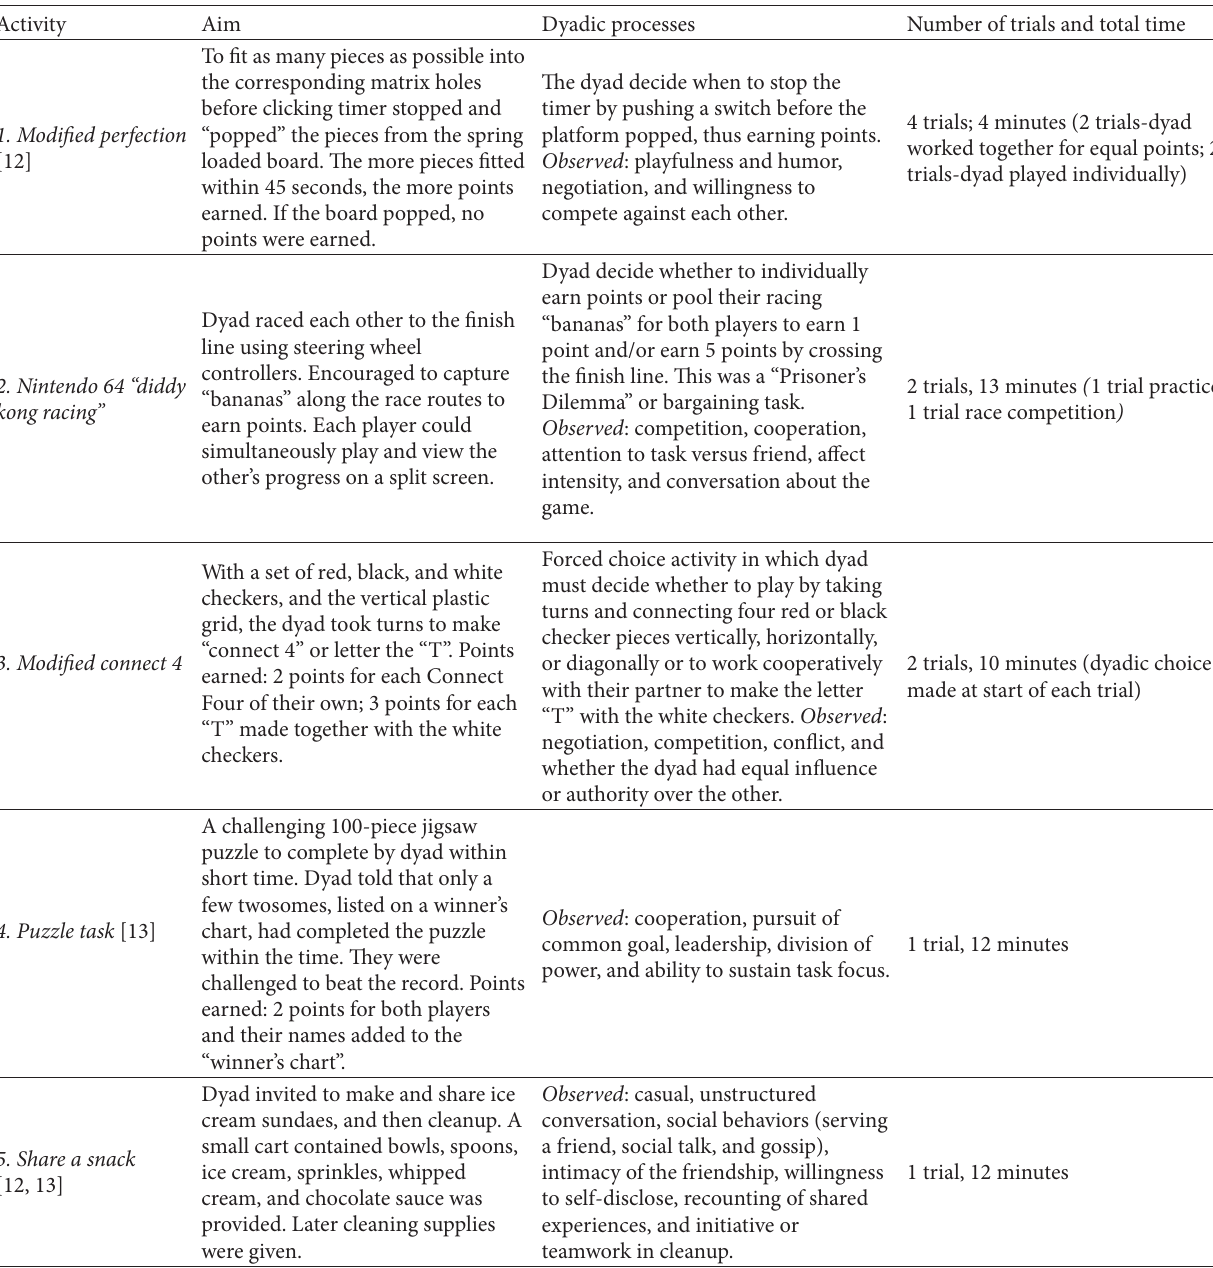
T 1: Sequence of dyad play session